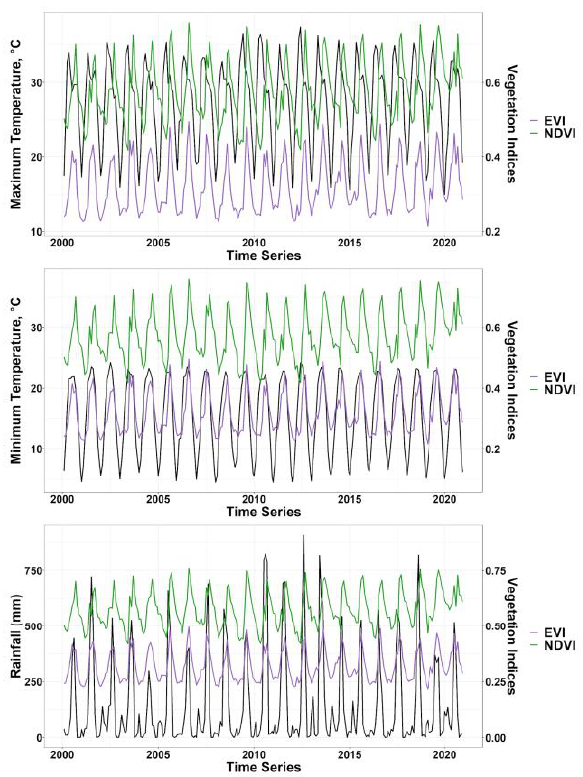
Figure 10. Temporal variation of vegetation indices and Climate Parameters in Dehradun District